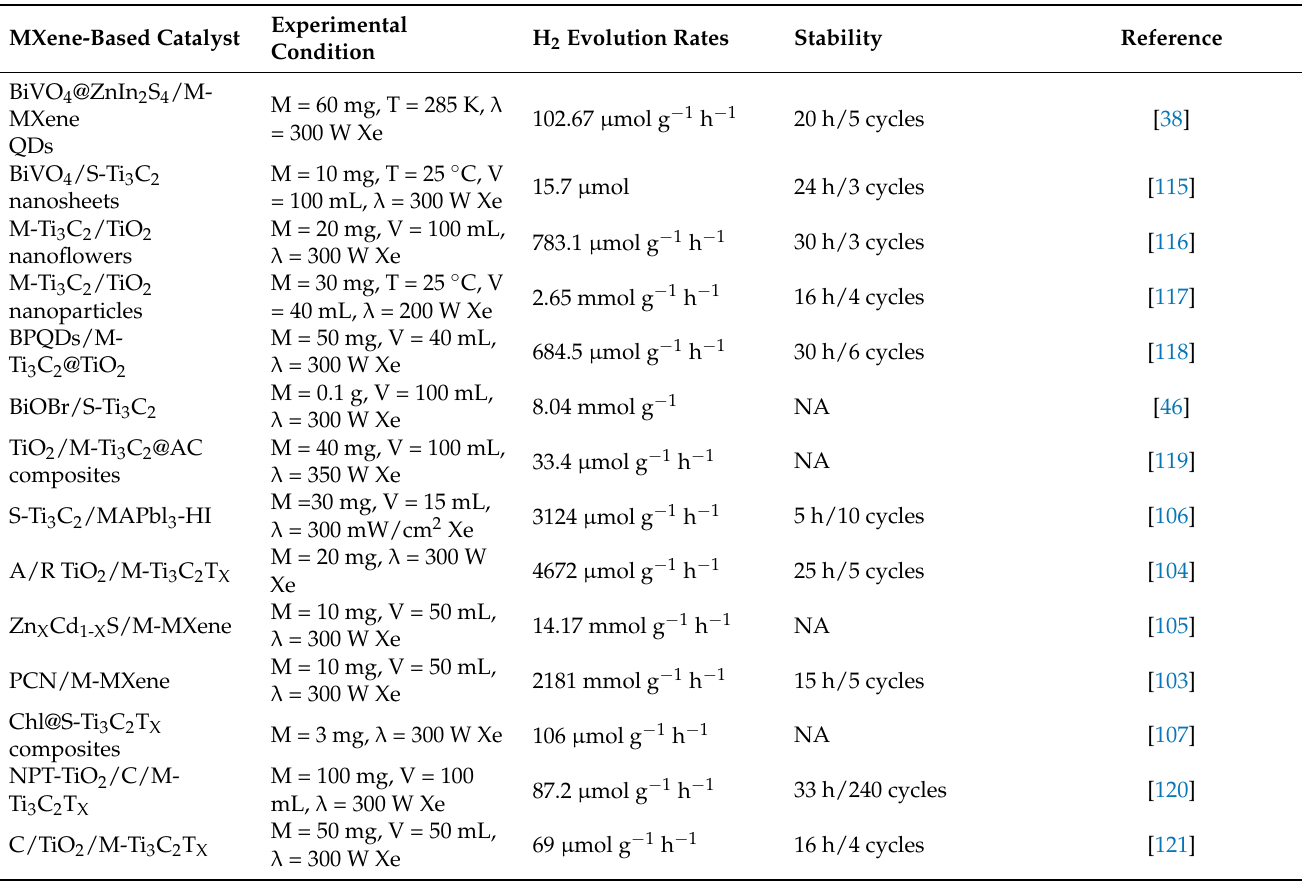
Table 4. Summary of MXene-based catalysts for water